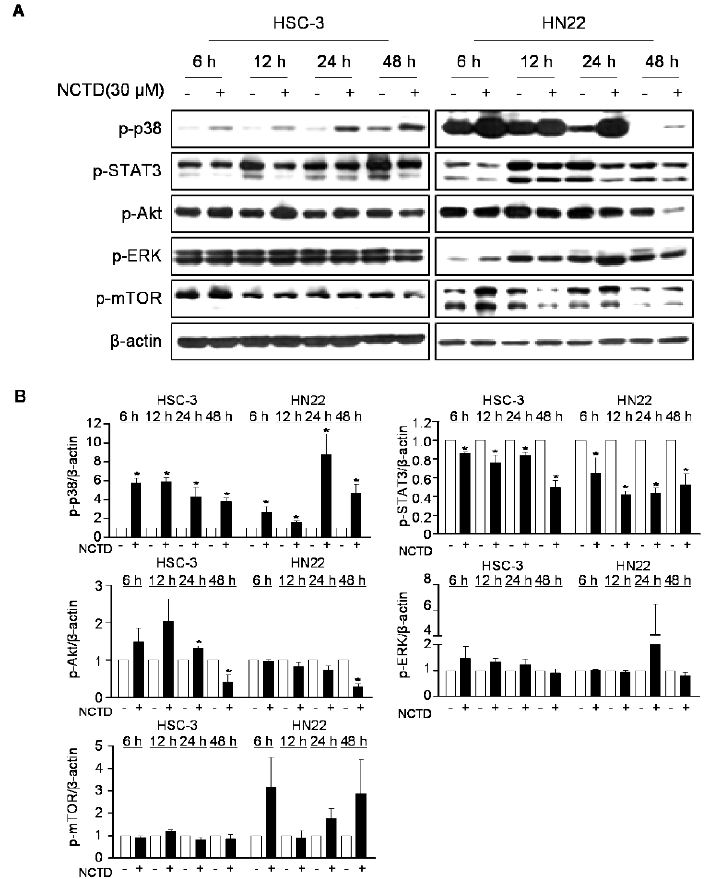
Figure 3. Effects of NCTD on oncogenic intracellular signaling pathways. Both cell lines were treated with 0 or 30 µ M for 6, 12, 24, or 48 h. ( A ) Phosphorylated forms of p38 mitogen-activated protein kinase (MAPK), signal transducer and activator of transcription (STAT)3, AKT, extracellular signal-regulated kinase (ERK), and mammalian target of rapamycin (mTOR) were measured by western blotting. ( B ) The graph represents the mean ± SD of three independent experiments, and significance compared with the control group was indicated (* p < 0.05).